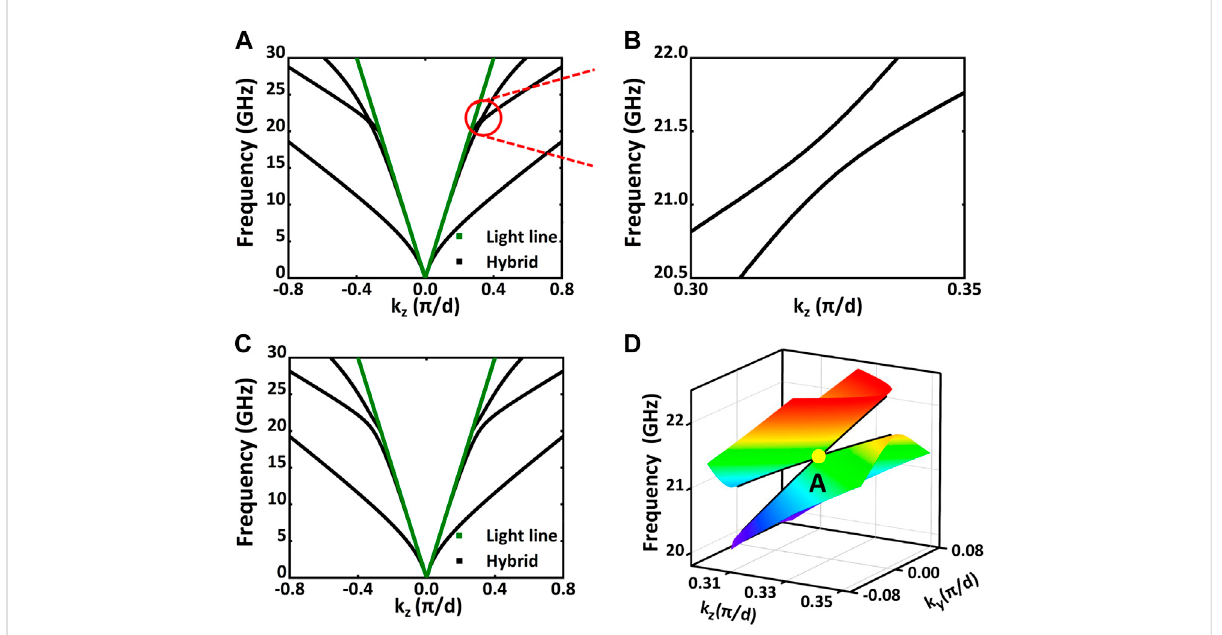
FIGURE 3 Type-II Dirac point in the dispersion diagram of the negatively uniaxial crystal slab when ε z (cid:1) 4 ε 0 . (A) Shows the dispersion relation when θ is chosen as 2 ° . (B) Zoom-in view of the band gap in (A) . (C) Shows the dispersion relation when θ = 10 ° . (D) 3D view around the degeneracy that gives rise to a type-II Dirac point in momentum